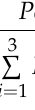
Figure A1. The data flowchart of the combined VR–EEG system.